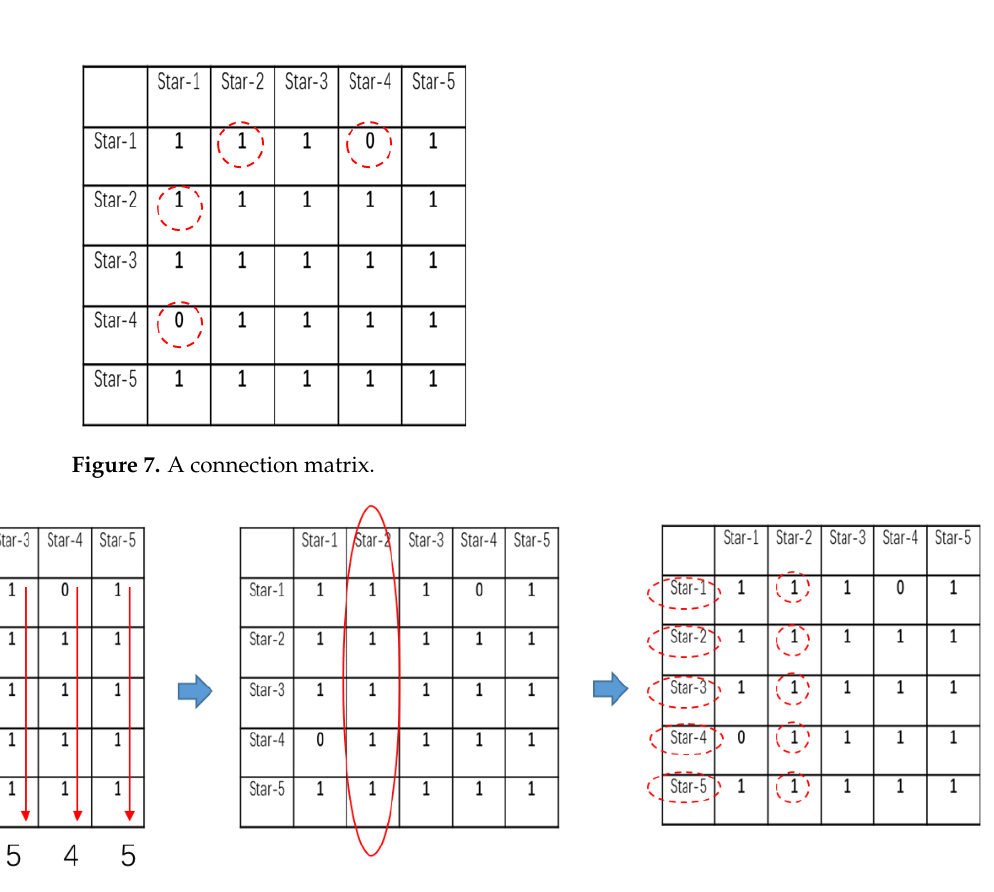
Figure 7. A connection matrix.